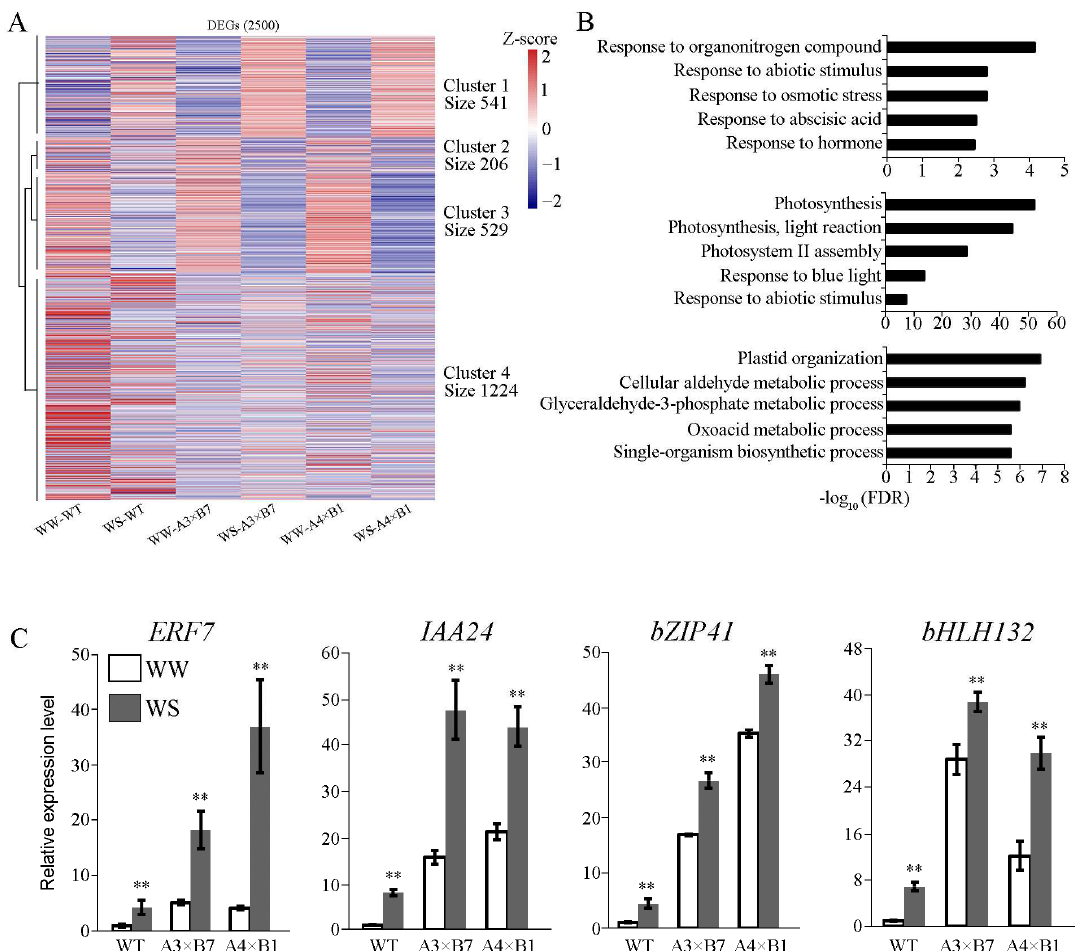
Figure 6. Cluster analysis of DEGs. ( A ) Hierarchical clustering analysis of 2500 DEGs. ( B ) AgriGO Gene Ontology enrichment analysis of biological pathway terms for Clusters 1–3. ( C ) qRT–PCR validation of increased gene expression for drought-responsive transcription factors in dual transgene maize seedlings under full irrigation or drought conditions. Data are average of three independent tests ± s.d. (** p < 0.01; two-sided t -test).